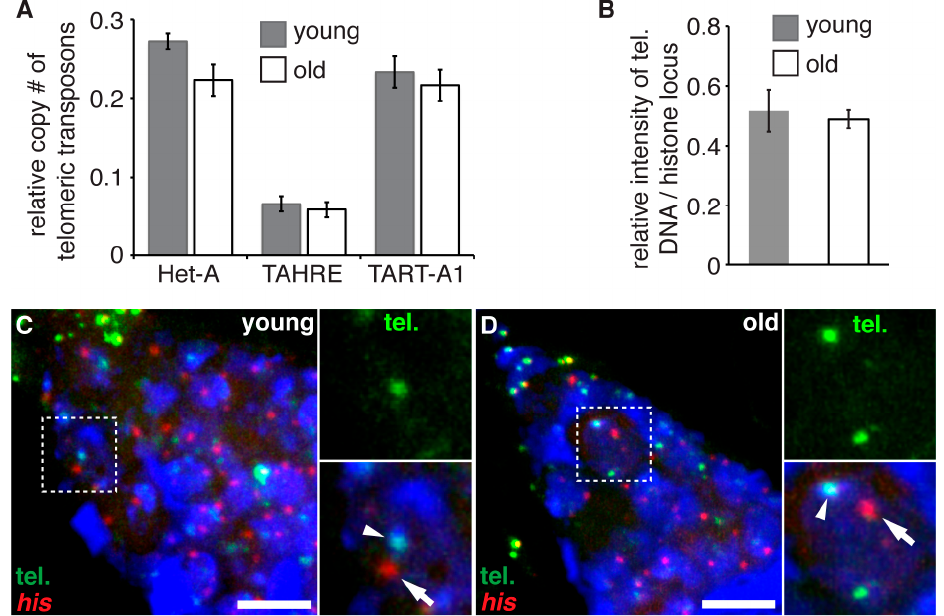
Figure 3. Aging does not lead to telomere shortening in GSCs. ( A ) Total DNA from the ovaries of young (2-day-old) and old (60-day-old) females were prepared and the copy numbers of three telomeric transposons Het-A , TARAE and TART-A1 were determined by real time PCR and plotted ( n = 3). A non-telomeric transposon Joecy was used as an internal control. ( B ) Quantifications of telomere (tel.) DNA contents by normalizing fluorescence in situ hybridization (FISH) signal of telomere DNA with FISH signal of his4 locus in GSCs of young and old females. No significant difference between young and old GSCs ( n = 100 for each group). ( C , D ) Representative images of two color FISH against telomere DNA (green, mix of three probes against all three telomeric transposons) and his4 locus (red) in young (( C ), 2-day-old) and old (( D ), 60-day-old) germaria. Box regions were enlarged for better illustrations of telomere DNA (arrowheads) and his4 locus (arrows). Scale bar: 5 µm.